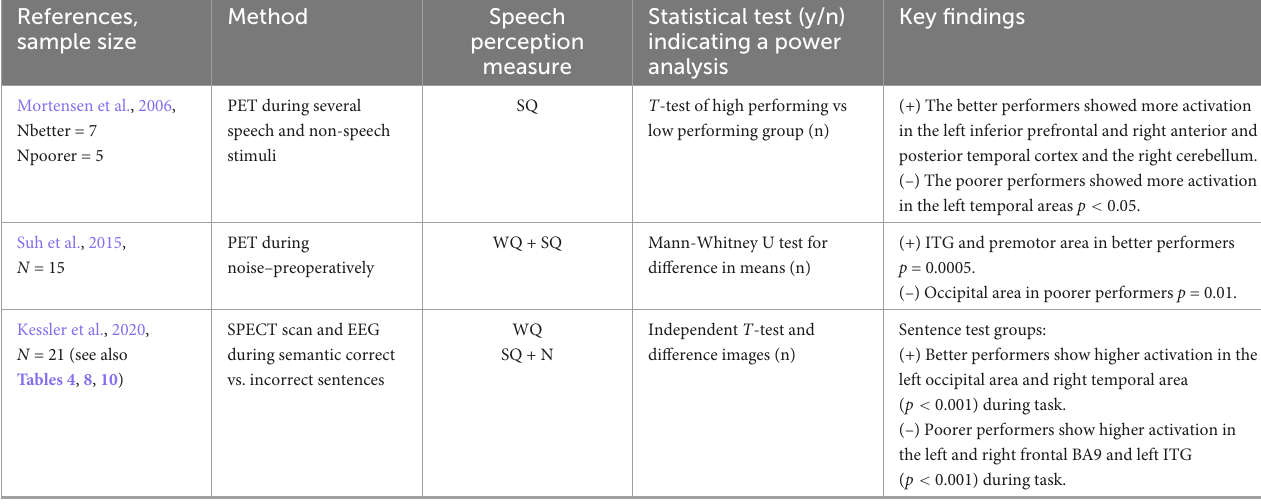
TABLE 1 Overview of included papers studying brain responses to auditory